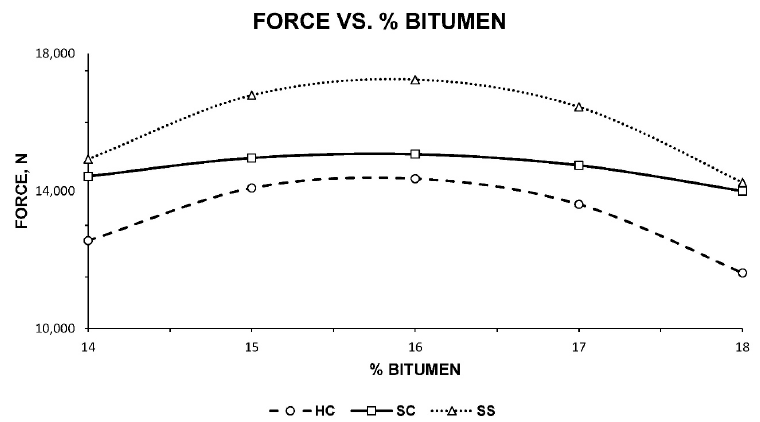
Figure 9. Marshall stability of the HC, SC, and SS families of bituminous mixtures according to the percentage of bitumen.